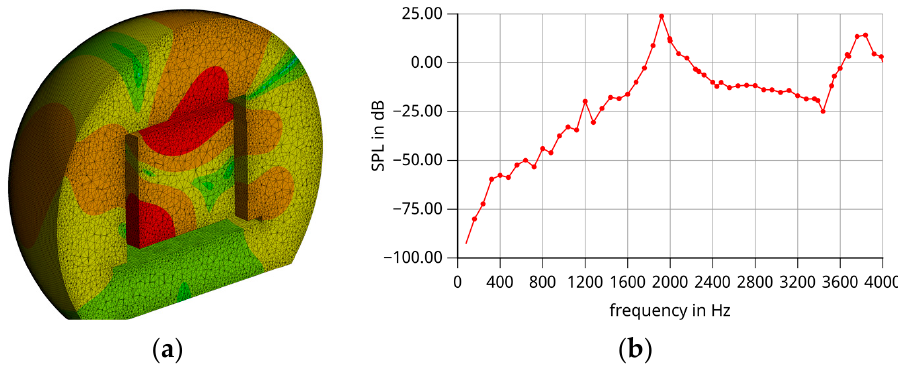
Figure 9. ( a ) FEA sound pressure result; ( b ) sound pressure spectrum.